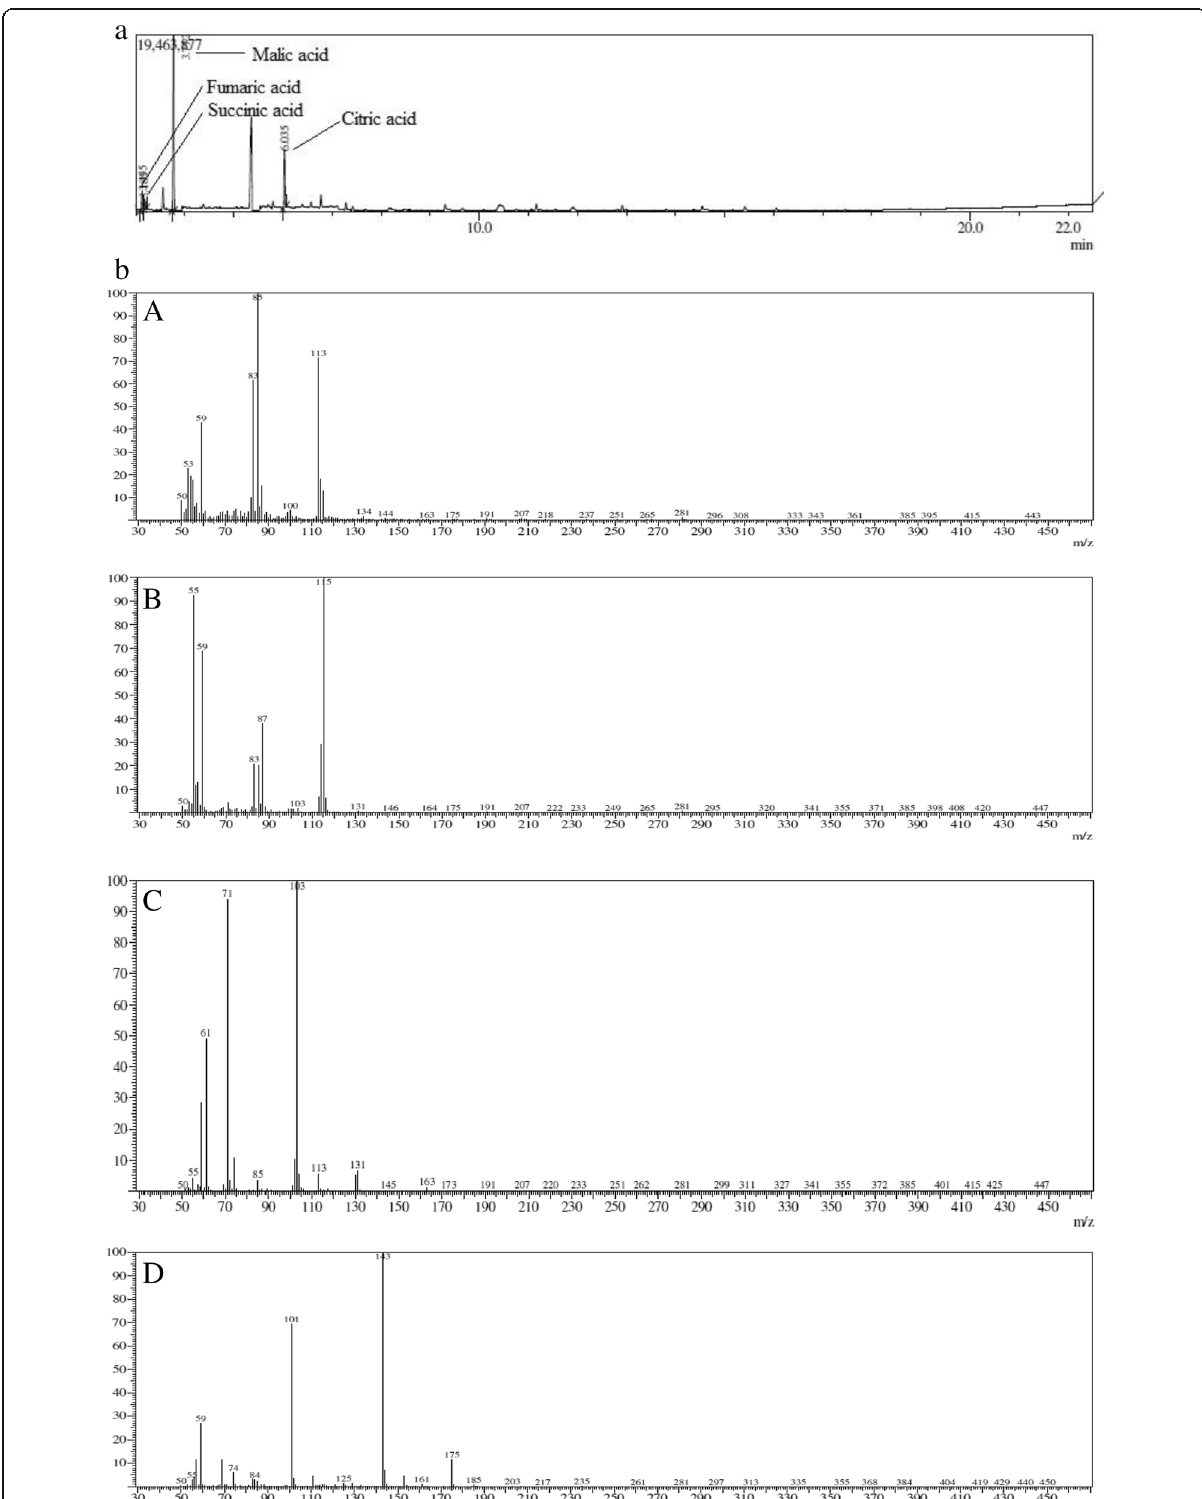
Fig. 1 a Total ion chromatogram of organic acid using GC-MS analysis. b Mass spectrums of organic acids obtained after GC-MS analysis. Fumaric acid dimethyester ( A ), succinic acid dimethyester ( B ), malic acid dimethylester, ( C ) and citric acid trimethylester ( D